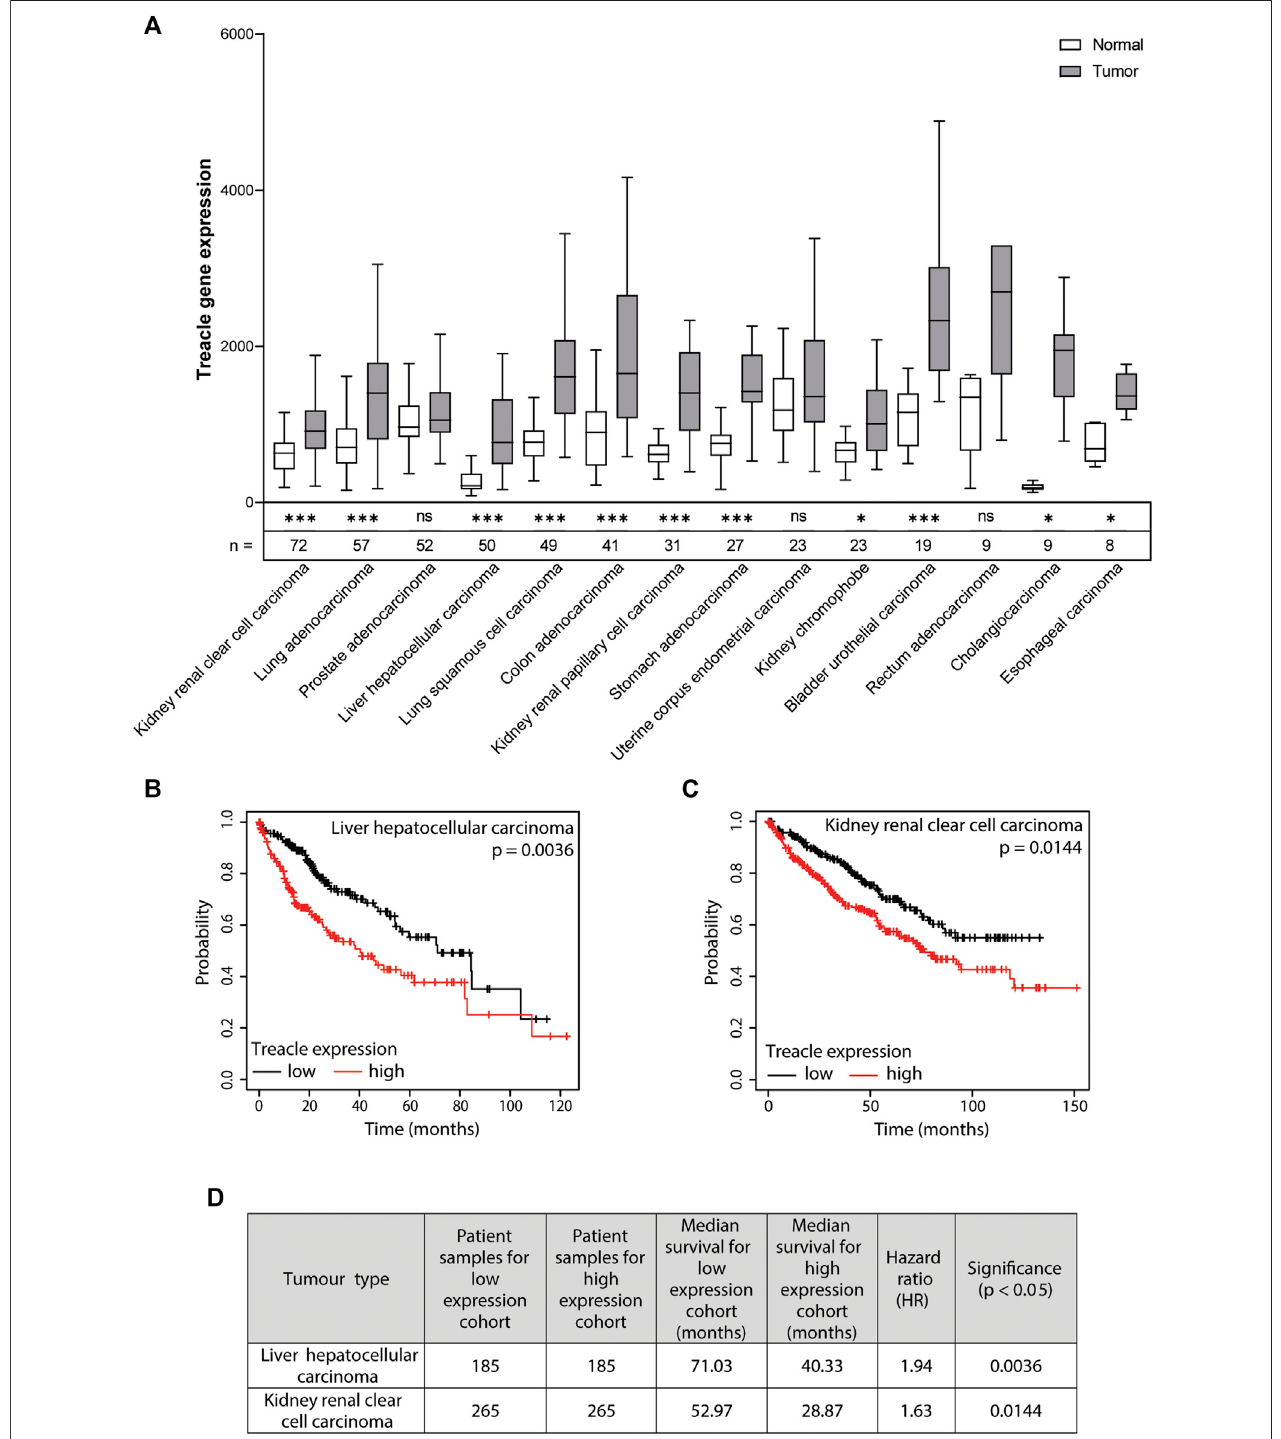
FIGURE 1 | Increased Treacle expression in cancer correlates with poor survival. (A) TNM plot: differential gene expression analysis of Treacle RNA-Seq data in paired normal and tumor tissue across anatomical sites (https://tnmplot.com/analysis/) (Bartha and Gy ő rffy, 2021). Signi fi cance of the difference in Treacle expression levels between paired normal and tumor tissue was estimated by TNM plot using a Mann-Whitney U test and the resulting p-values were FDR-adjusted prior to assessment of signi fi cant correlations [ p < 0.05 (* > 0.05, ** > 0.01, *** > 0.001)]. (B, C) Kaplan-Meier survival analysis with strati fi cation according to expression levels of Treacle based on the median cut-off between the lower and upper quartile (https://kmplot.com/analysis/index.php?p=service&cancer=pancancer_rnaseq)